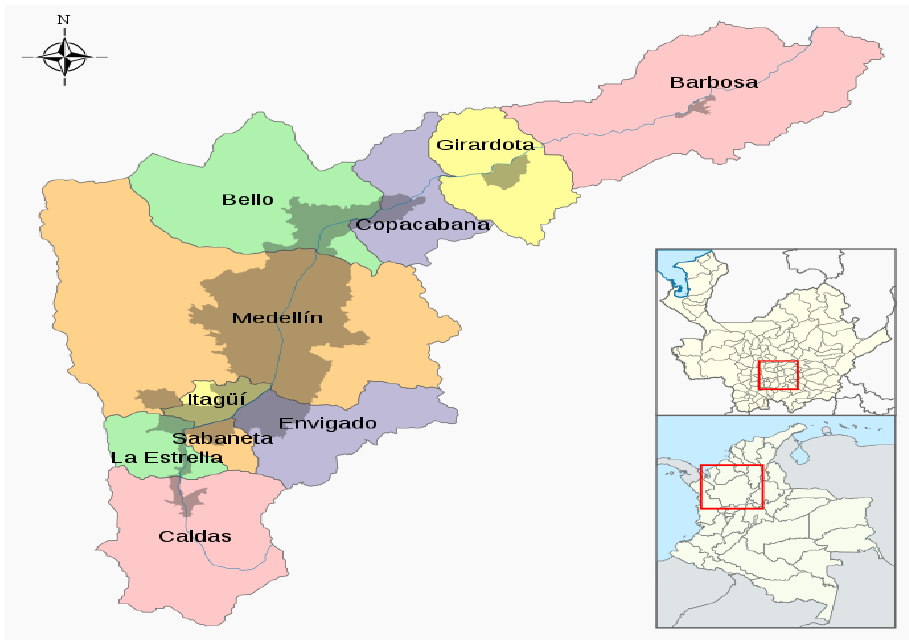
Figure 1. Map of Valle de Aburrá.